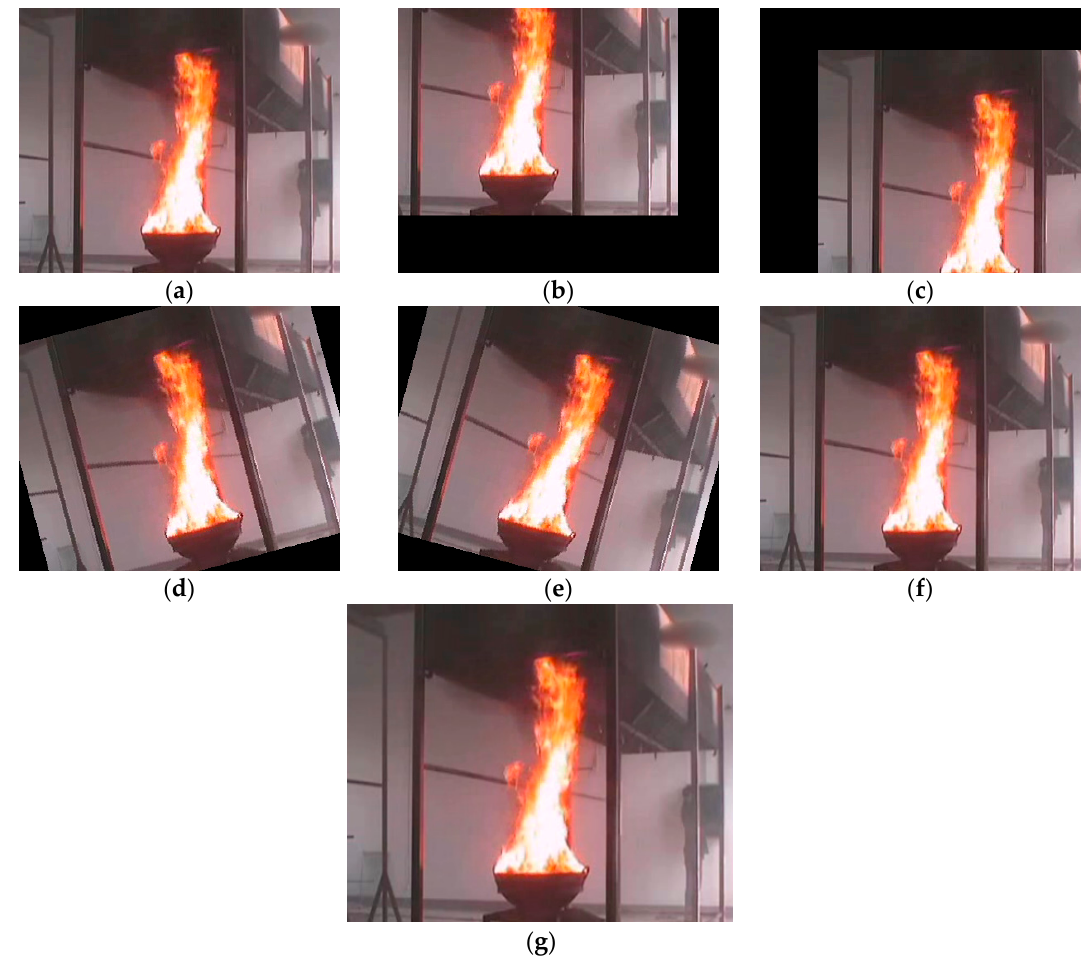
Figure 6. Effect of training dataset size on recognition rate.